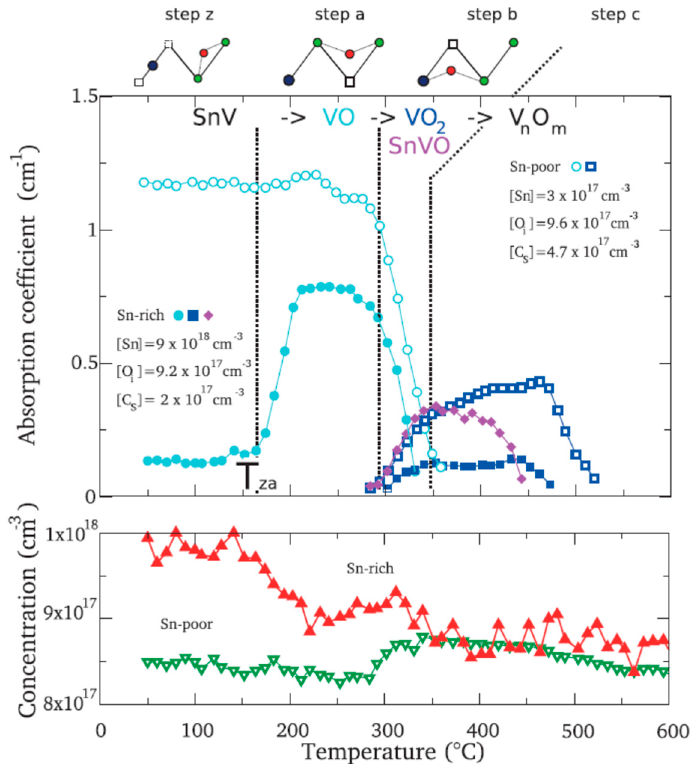
Figure 15. The thermal evolution of the A-center, VO 2 , and SnVO defects for samples with Sn-poor content and Sn-rich content. The constituent defects are sketched using red circles for the oxygen atoms, blue and green circles for the D and Si atoms, respectively. The square and dotted square represent the V and semi-vacancies. The thermal evolutions of the Oi for Sn-poor and Sn-rich concentrations are given at the bottom of the figure Reprinted with permission from [93]. American Institute of Physics, 2011.